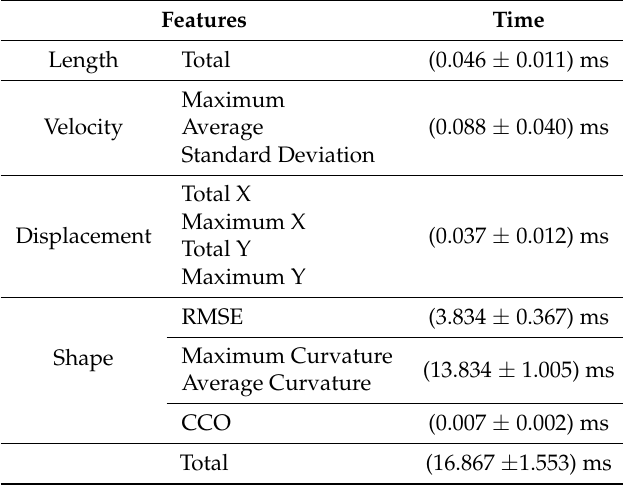
Table 2. Computation time (Avg. ± SD) of every feature